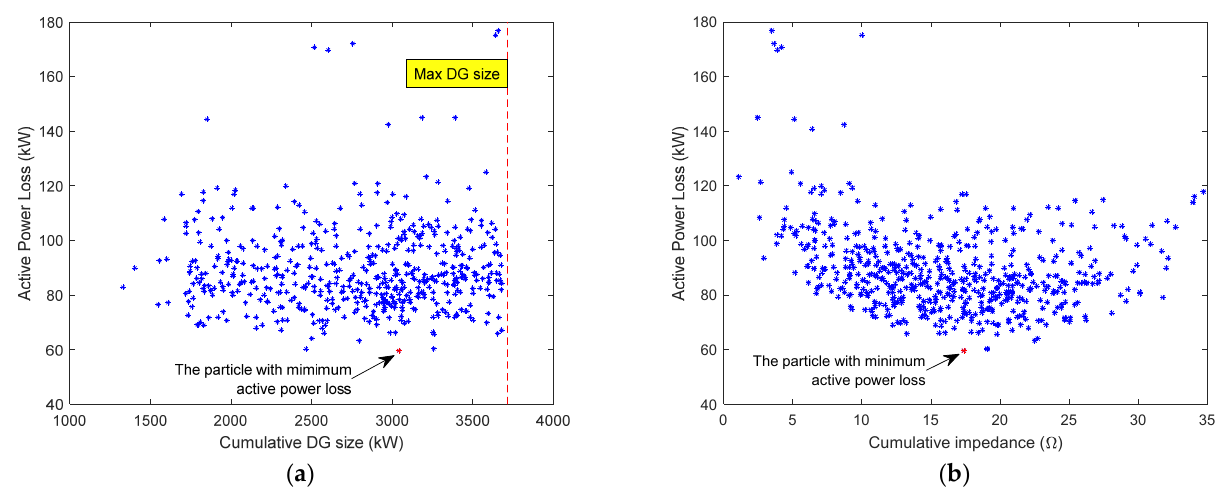
Figure 9. Variation of active power loss with ( a ) the cumulative DG sizes and ( b ) the cumulative impedance of possible solutions that were obtained from the best run of the fourth network structure.